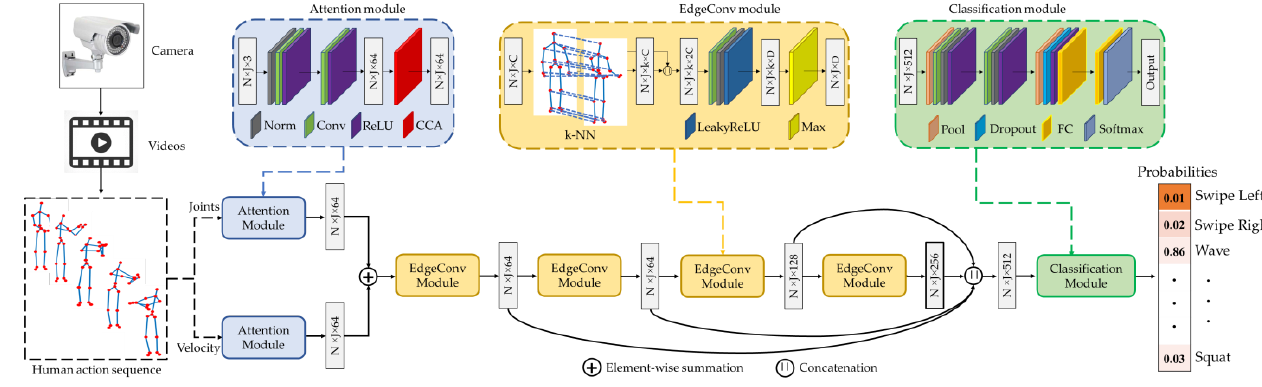
Figure 7. Overall working principle of the proposed dynamic edge convolutional neural network for human action recognition. human action